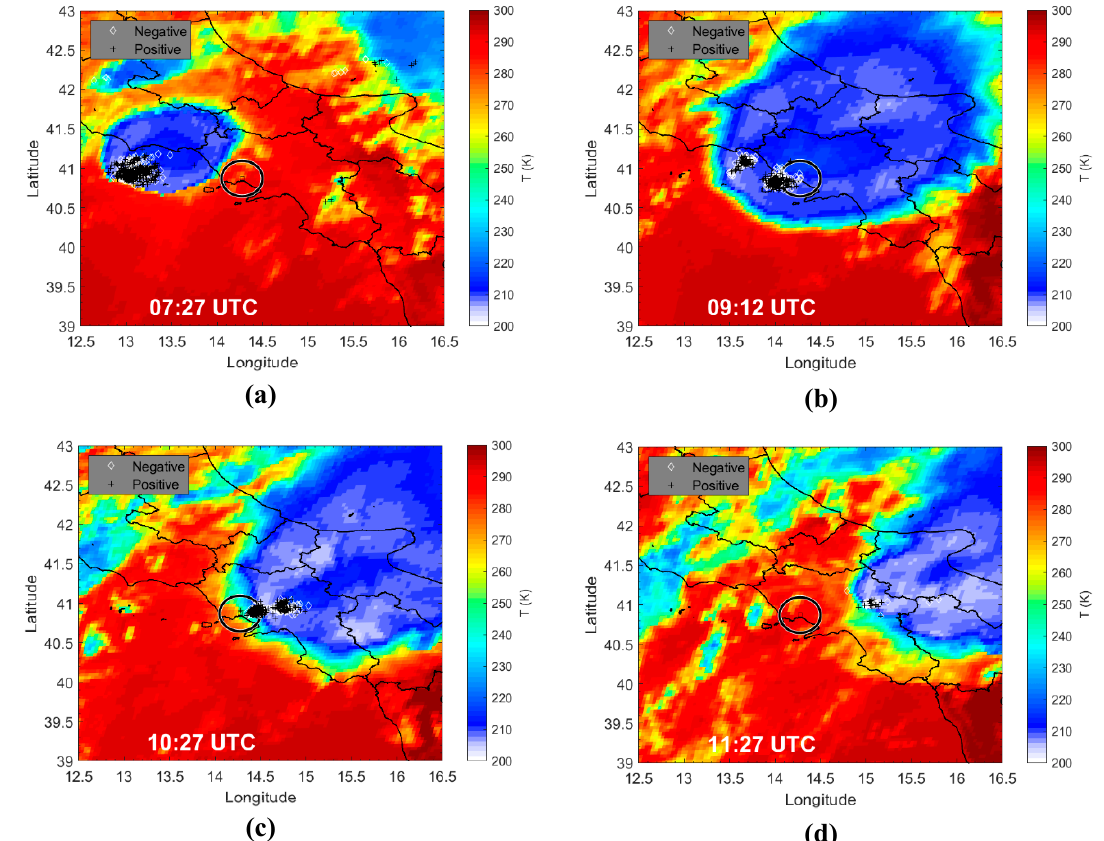
Figure 2. Time evolution of the convective cell hitting the Naples area on 5th September 2015. The panels ( a ) to ( d ) report the brightness temperature (TB) as measured by SEVIRI channel 9 and the positive (black crosses) and negative (white diamonds) strokes as recorded by the LINET network at ( a ) 07:27, ( b ) 09:12, ( c ) 10:27, and ( d ) 11:27 UTC, respectively. The black circle is centred in correspondence of GPS antenna and identifies the area where its measurements are consistent (i.e., around a 25-km radius).